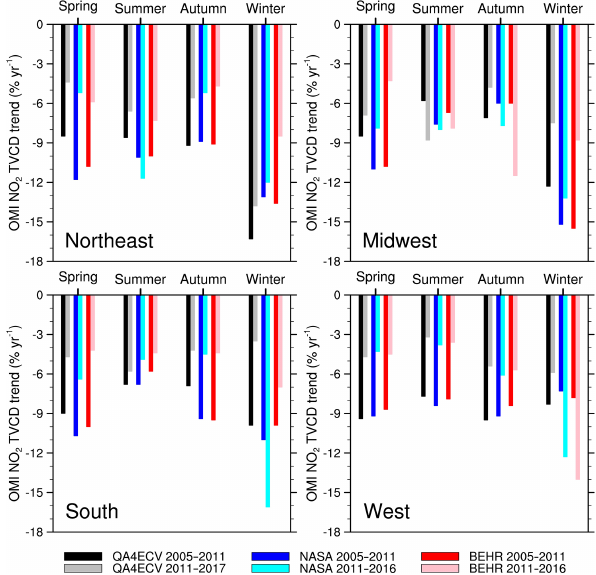
Figure 7. Pre- and post-2011 OMI NO 2 TVCD trends for four sea- sons in the urban regions of Northeast, Midwest, South, and West. Black bars denote OMI-QA4ECV NO 2 TVCD trends from 2005 to 2011; gray bars denote the corresponding trends during 2011– 2017. Blue bars denote OMI-NASA trends from 2005 to 2011; cyan bars denote OMI-NASA trends from 2011 to 2016. Red bars de- note OMI-BEHR trends from 2005 to 2011; pink bars denote OMI- BEHR trends from 2011 to